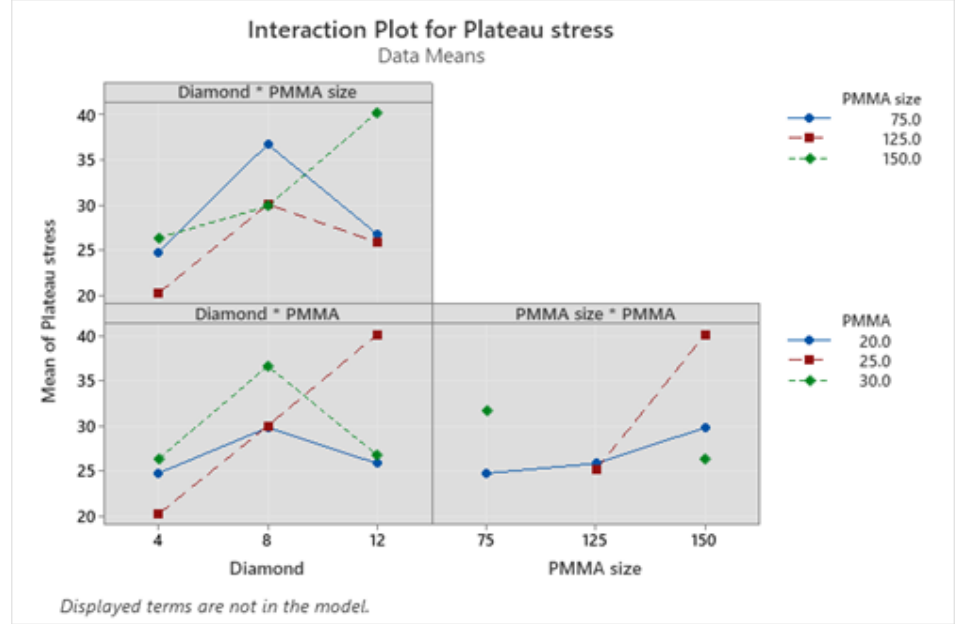
Figure 11. Interaction plots for plateau stress.